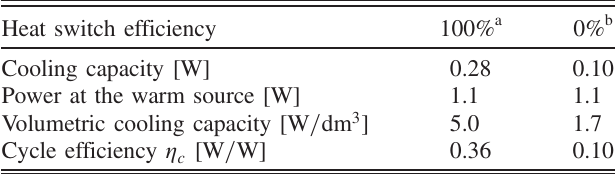
TABLE V. Small scale prototype calculations